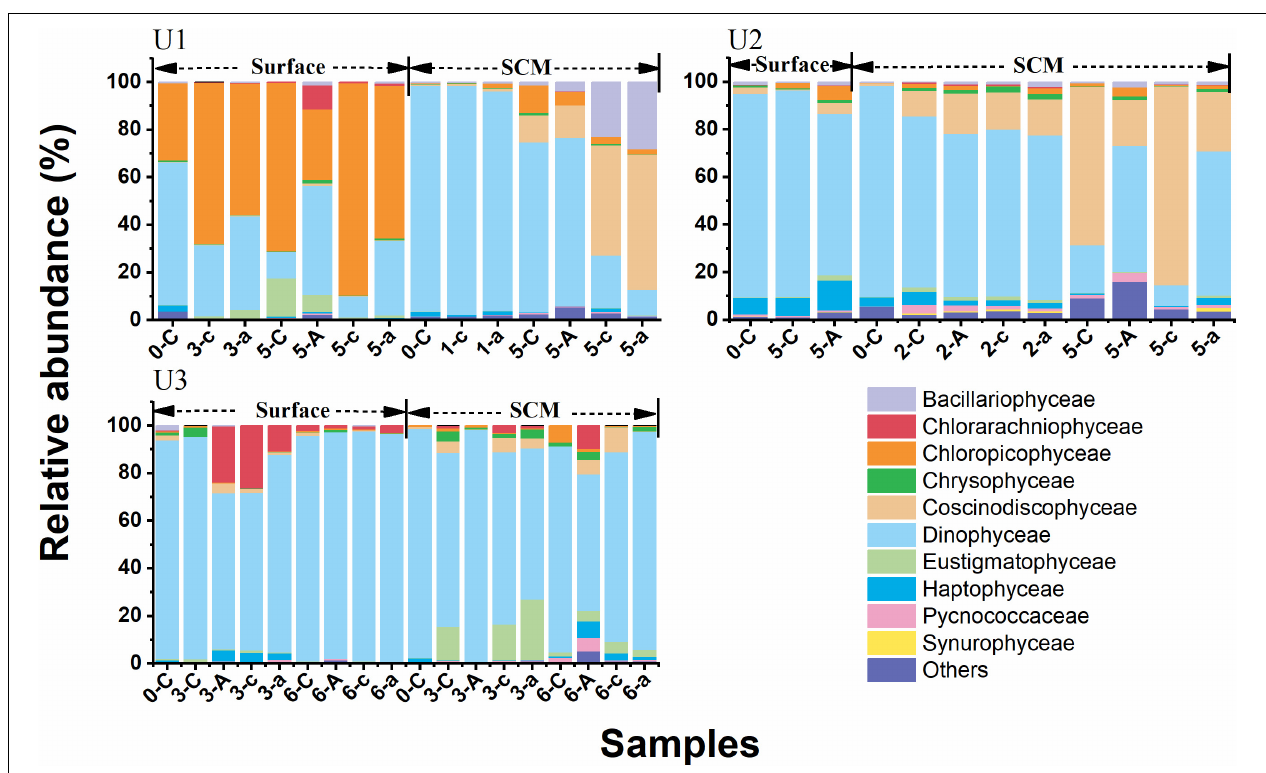
FIGURE 6 | Relative abundances of dominant eukaryotic phytoplankton classes (level 3 of the taxonomic hierarchy in SILVA 132) in the control and AR treatments during the incubation experiments; -C, -A, and -c, -a refer to the control, and AR treatments in the unfiltered and filtered seawaters, e.g., 0-C means on day 0 in the unfiltered seawater for the control treatment. “Others” refers to the groups outside of the top